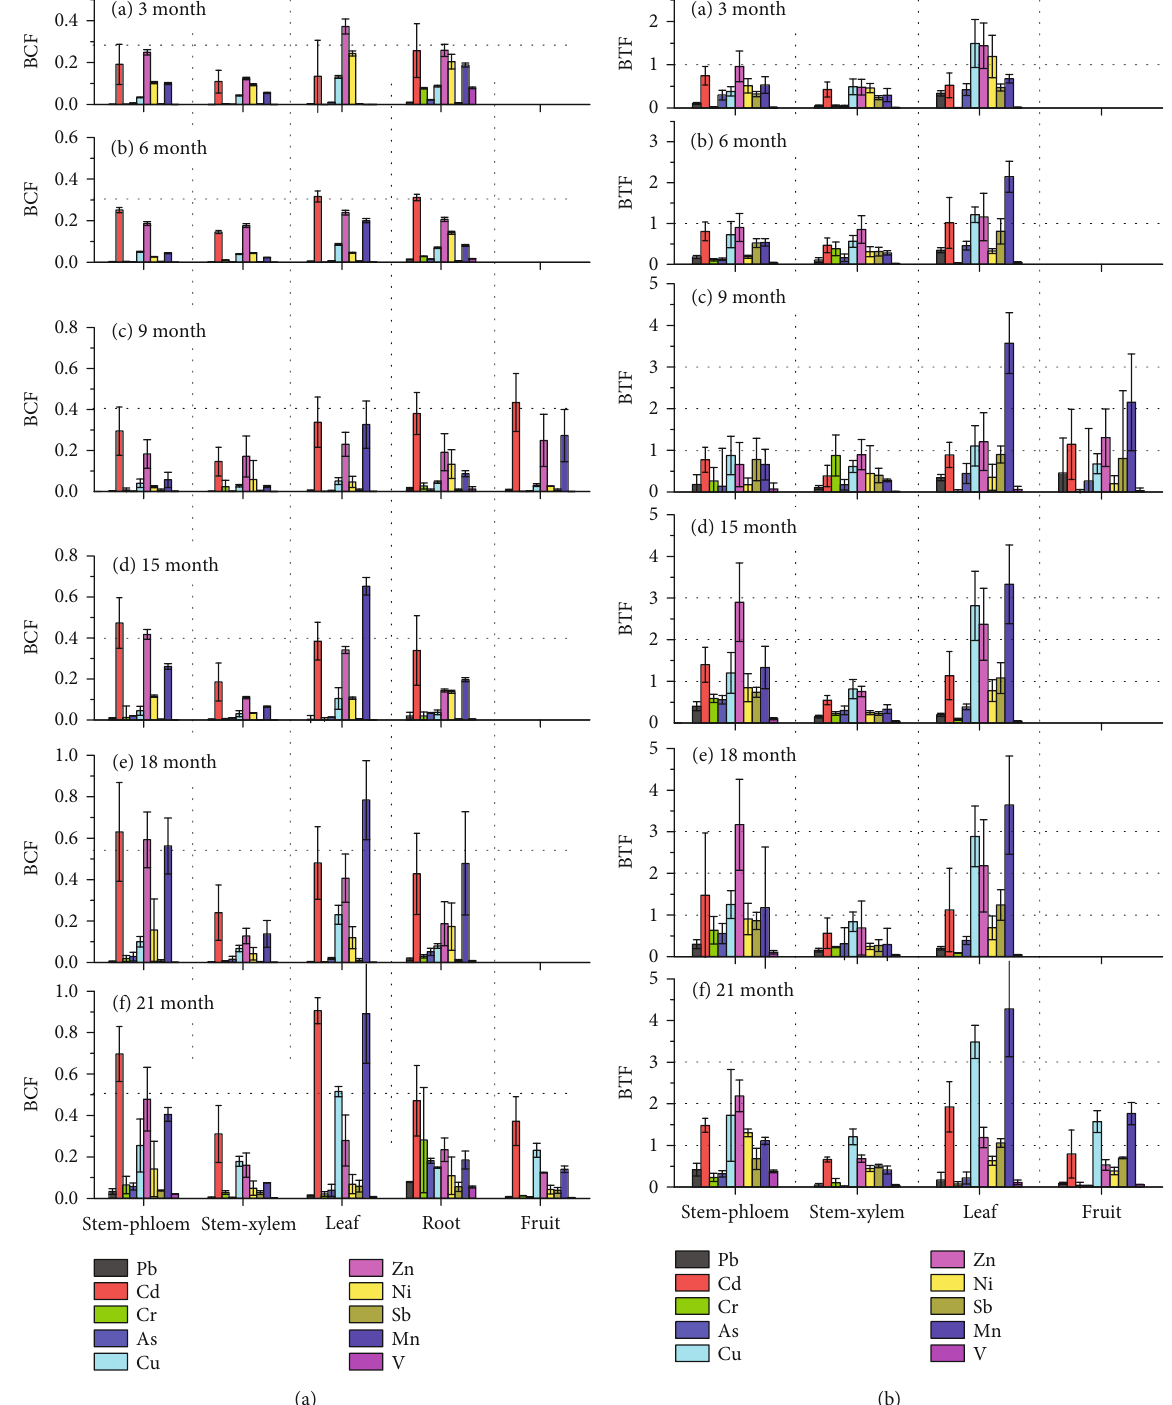
Figure 6: The (a) BCF and (b) BTF of heavy metal in di ff erent organs of Indigofera amblyantha Craib. The error bar was the standard